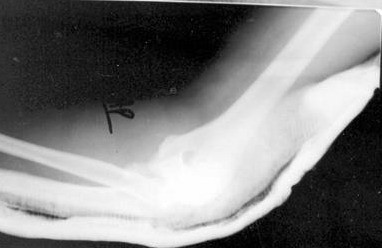
Lateral radiographs of his left elbow showed the Monteggia fracture dislocation.